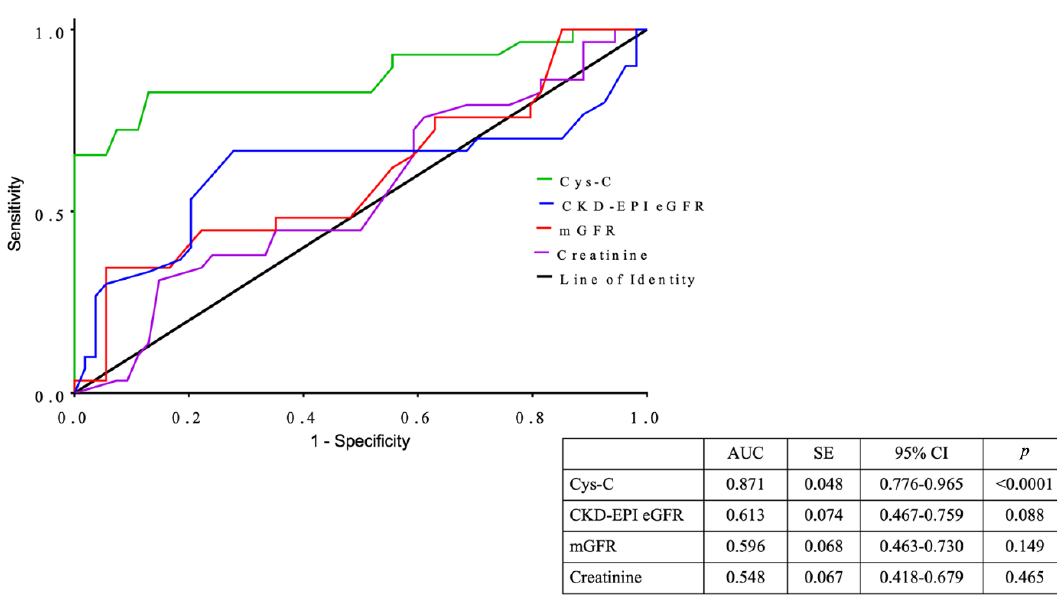
Figure 4. Receiver operating characteristic (ROC) curves of renal functional parameters for prediction of L-T4 treated hypothyroid patients with suboptimal TSH values (>2.0 µIU/mL). AUC = area under curve; SE = standard error; CI = confidence interval.